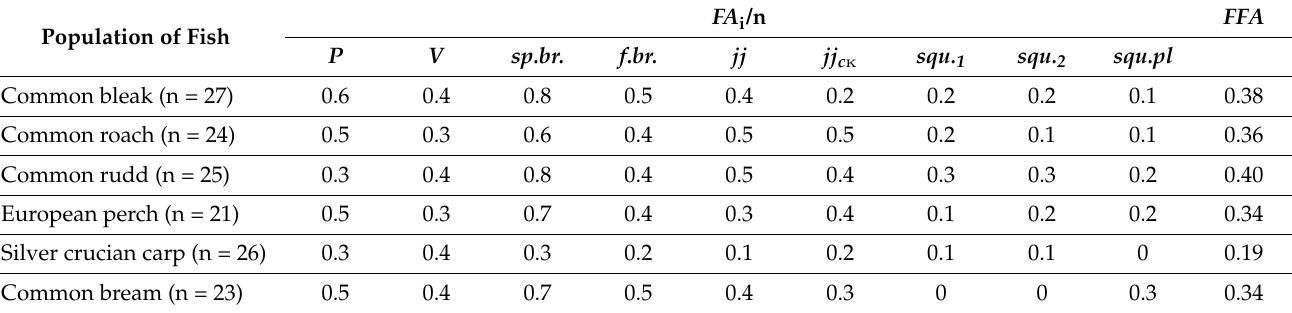
Table 6. The FFA for each studied fish population in the Ustya River at sampling site No. 4 ( p ≤ 0.05).